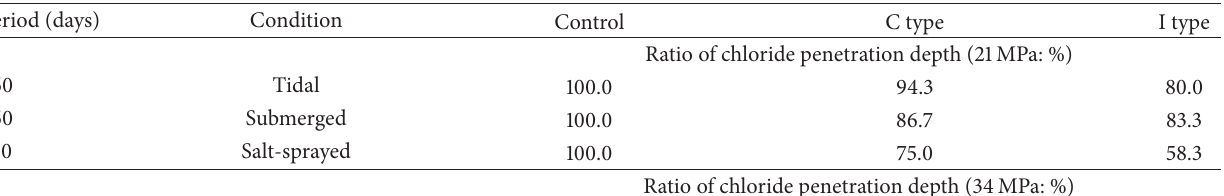
Table 6: Decrease ratio of chloride penetration depth.